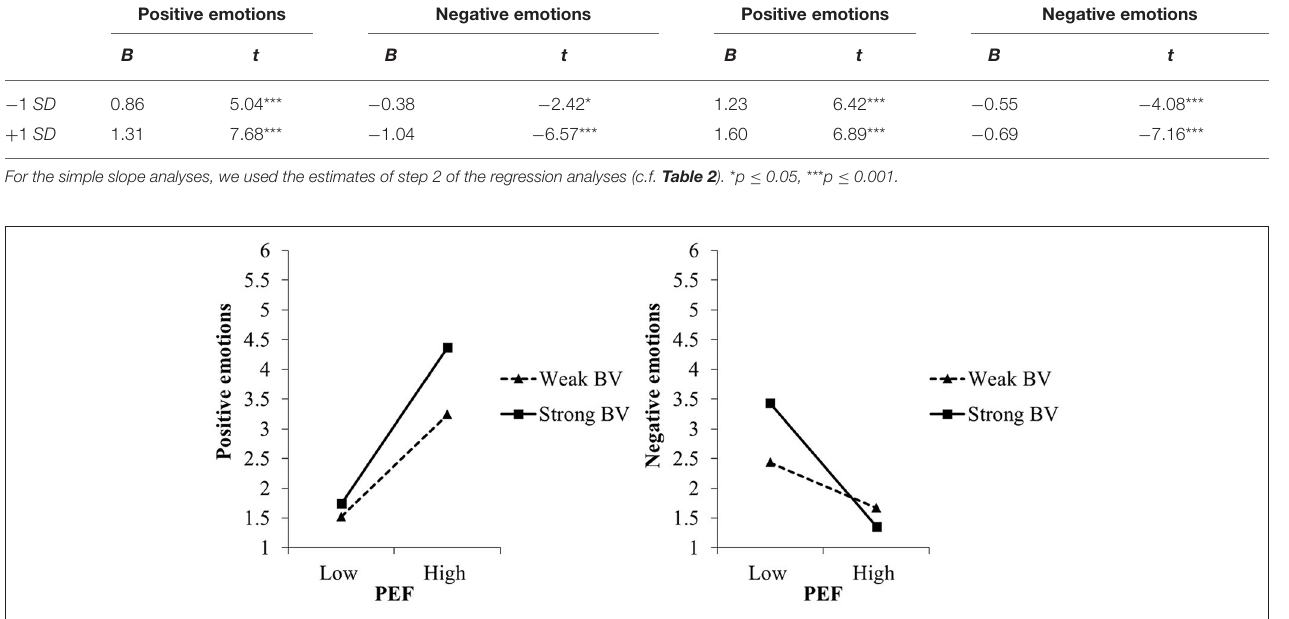
TABLE 3 | Simple slopes of innovations’ perceived environmental friendliness explaining positive and negative emotions toward the innovations at ± 1 standard deviation (SD) of biospheric values. Experiment I ( n = 50): Microalgae-based foods